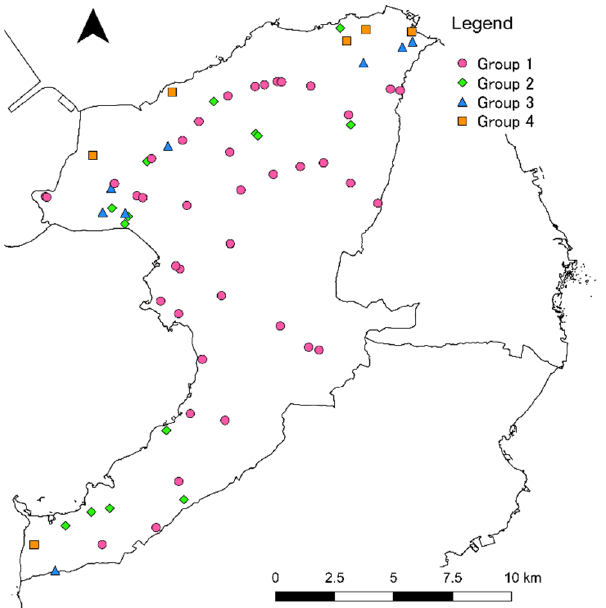
Figure 8. Distribution of each pollution group.